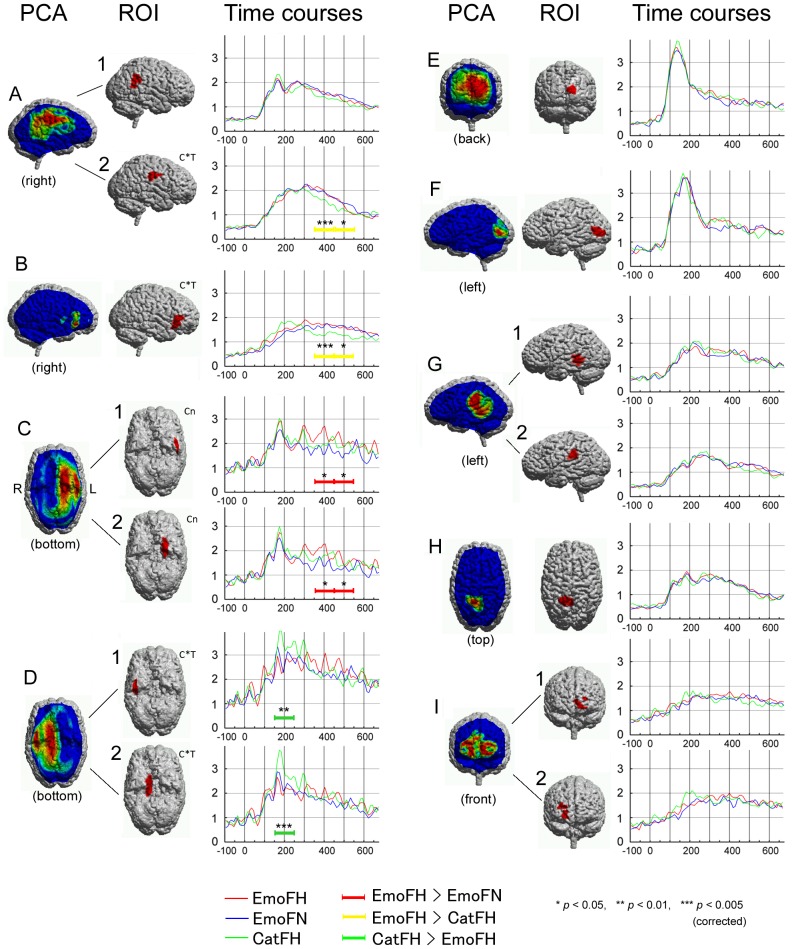
Results of the PCA-based ROI analysis.The PCA column shows the spatial distribution of nine factors extracted by PCA. Views of the brains are indicated in parentheses. The shape of each ROI created by these PCA factors is shown in the ROI column. C*T indicates ROIs that showed significant interaction (condition * TW), and Cn indicates ROIs that showed significant main effects of condition. Time courses of CSD at each ROI averaged across the 16 subjects are displayed on the right-hand side of the corresponding ROIs. Time courses of the 3 conditions are plotted in red (EmoFH), blue (EmoFN), and green (CatFH). The unit of the Y-axis demonstrates the median-normalized value. Time windows, during which statistically significant condition differences were detected by post hoc analyses, are indicated in red (EmoFH > EmoFN), yellow (EmoFH > CatFH), and green (CatFH > EmoFH) bars.